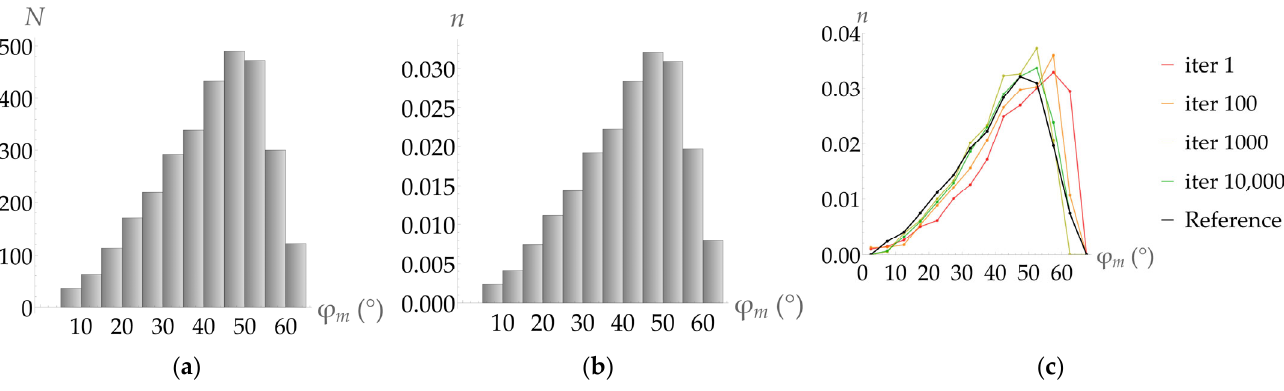
Figure 3. ( a ) The histogram for the distribution of mutual misorientation angles in the φ in the m copper polycrystal at temperature T = 773 and deformation ε u = 0.15. ( b ) The normalized histogram copper polycrystal at temperature T = 773 and deformation   0.15 . ( b ) The normalized histo ‐ u for the angles ϕ norm m . ( c ) The evolution of the empirical ( ϕ norm m ) distribution function during the gram for the angles φ norm . ( c ) The evolution of the empirical ( φ norm ) distribution function during m m optimization the optimization procedure.